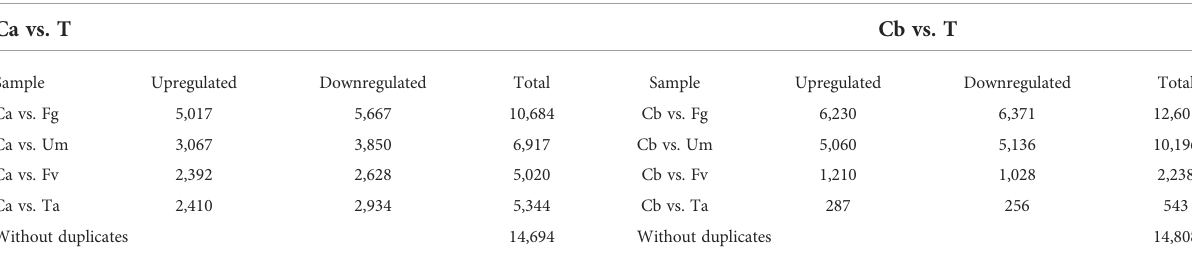
TABLE 1 Differentially expressed gene analysis of fungal infected transcriptomic data of maize silk. Differentially expressed genes Ca vs.